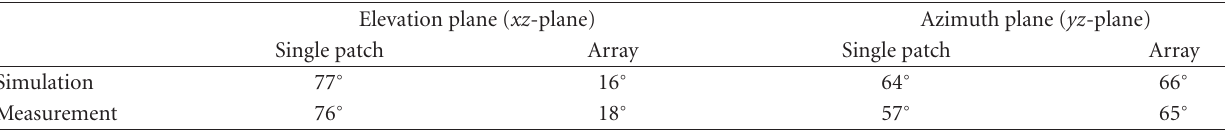
Figure 2: Top view of the textile antenna array and its position on the human body. TX1 to TX4 from top to bottom. W and L are the dimensions of the ground plane, as indicated in Table 1. The antenna array is placed on the back of the body, inside the firefighter jacket. Table 2: Simulated and measured − 3dB beam width of a single-patch antenna and of the array, in the elevation plane ( xz -plane) and in the azimuth plane ( yz